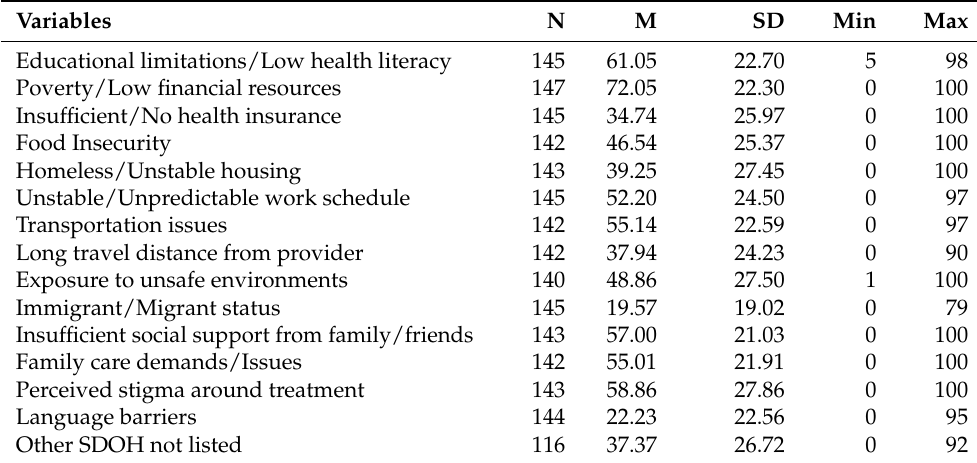
Table 2. Healthcare provider reports on the portion of their patients experiencing social determinants of health